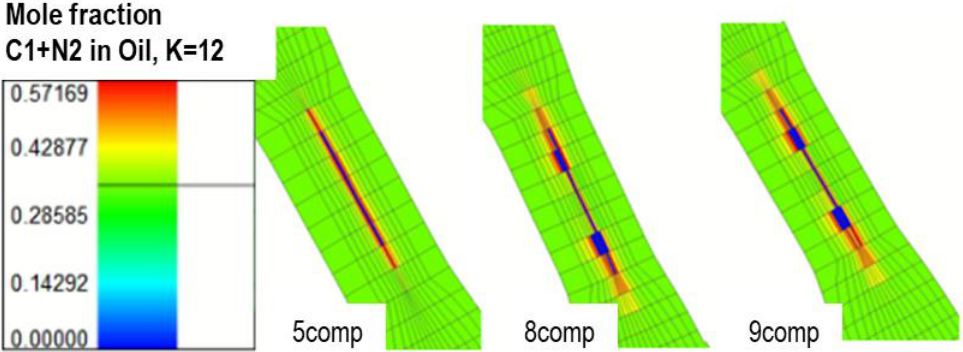
Figure 10. The molar fraction of the N2 + C1 on 01.02.2019.